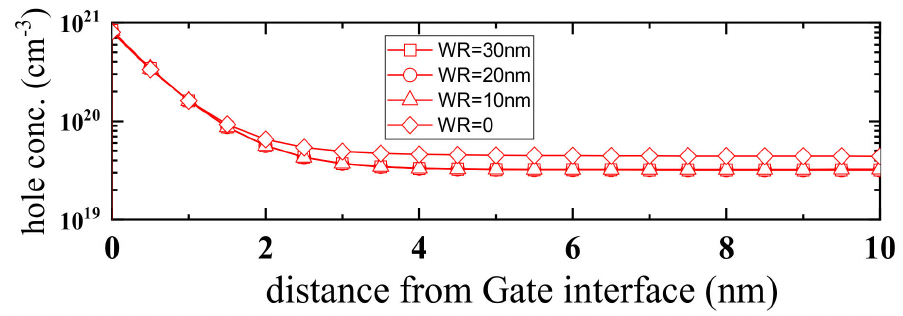
Figure 3. Cutline of the hole concentration along the transversal direction y (x = 0) at the end of a WRITE operation (t WRITE = 5 ns) at the bias V D = − V G = 2